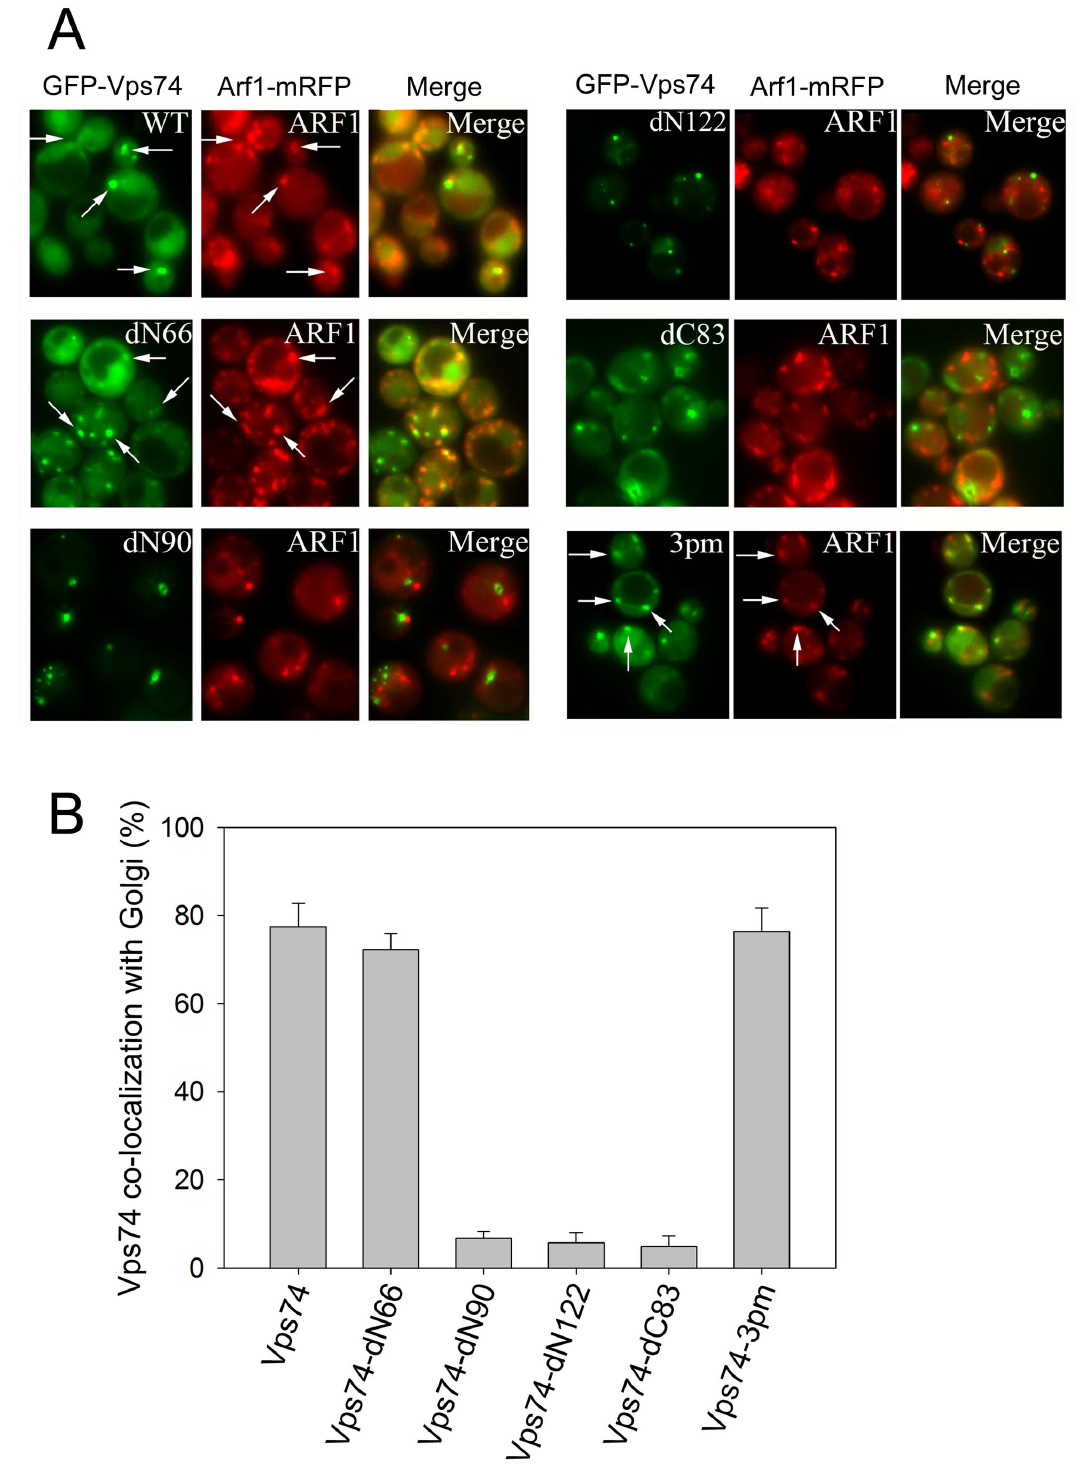
Figure 2. Vps74p is localized to the Golgi apparatus. N-terminal GFP-fused-Vps74p, -Vps74p-dN66, -Vps74p-dN90, -Vps74p- dN122, -Vps74p-dC83, and -Vps74p-3pm from a 2μ vector (pVT101U) under an ADH promoter were transformed into vps74 - deleted yeast cells containing Arf1p-mRFP. Mid-log phase cells were imaged live via microscopy. (B) The quantitative measurements of the Golgi co-localization are presented. doi: 10.1371/journal.pone.0074715.g002 PLOS ONE |